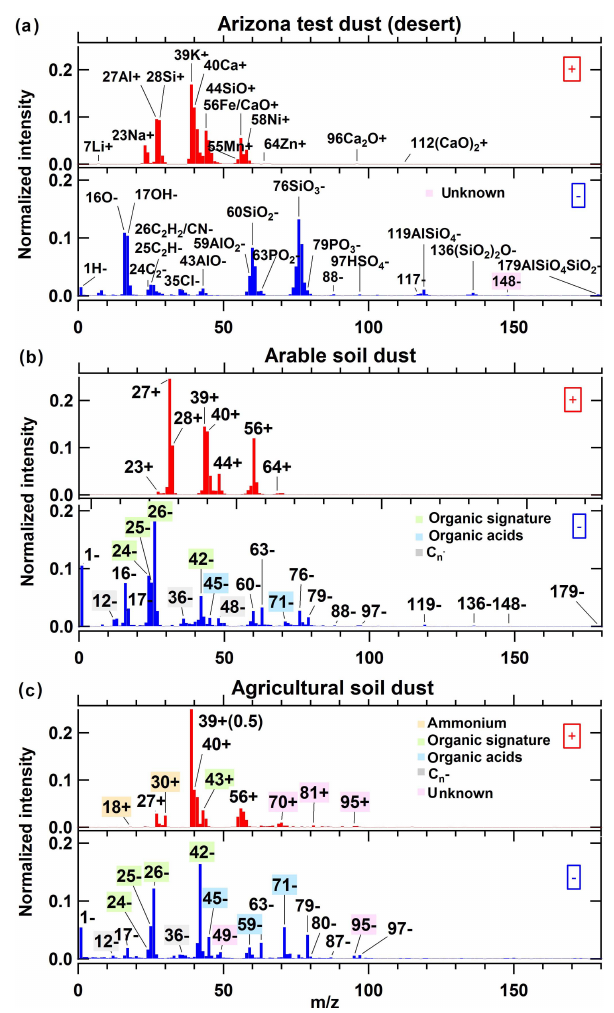
Figure 7. Average mass spectra for particles of complex mix- tures: (a) Arizona test dust (desert dust), directly sampled into the LAAPTOF from a shaked bottle (b) arable soil dust, collected from Gottesgabe in Germany, was dispersed by a rotating brush genera- tor and injected via cyclones into the AIDA chamber at 256K and 80% RH, and (c) agricultural soil dust, collected from harvesting machines after rye and wheat harvest, were generated by using the same method as (b) . For (b) and (c) , fragments labelled in green rep- resent more intensive organic signatures in soil dust particles; grey labels represent EC patterns; blue labels represent organic acids; orange labels represent ammonium salts; red labels represent un- known fragments. The numbers of spectra averaged for each spec- trum are 261 (a) , 583 (b) , and 286 (c)